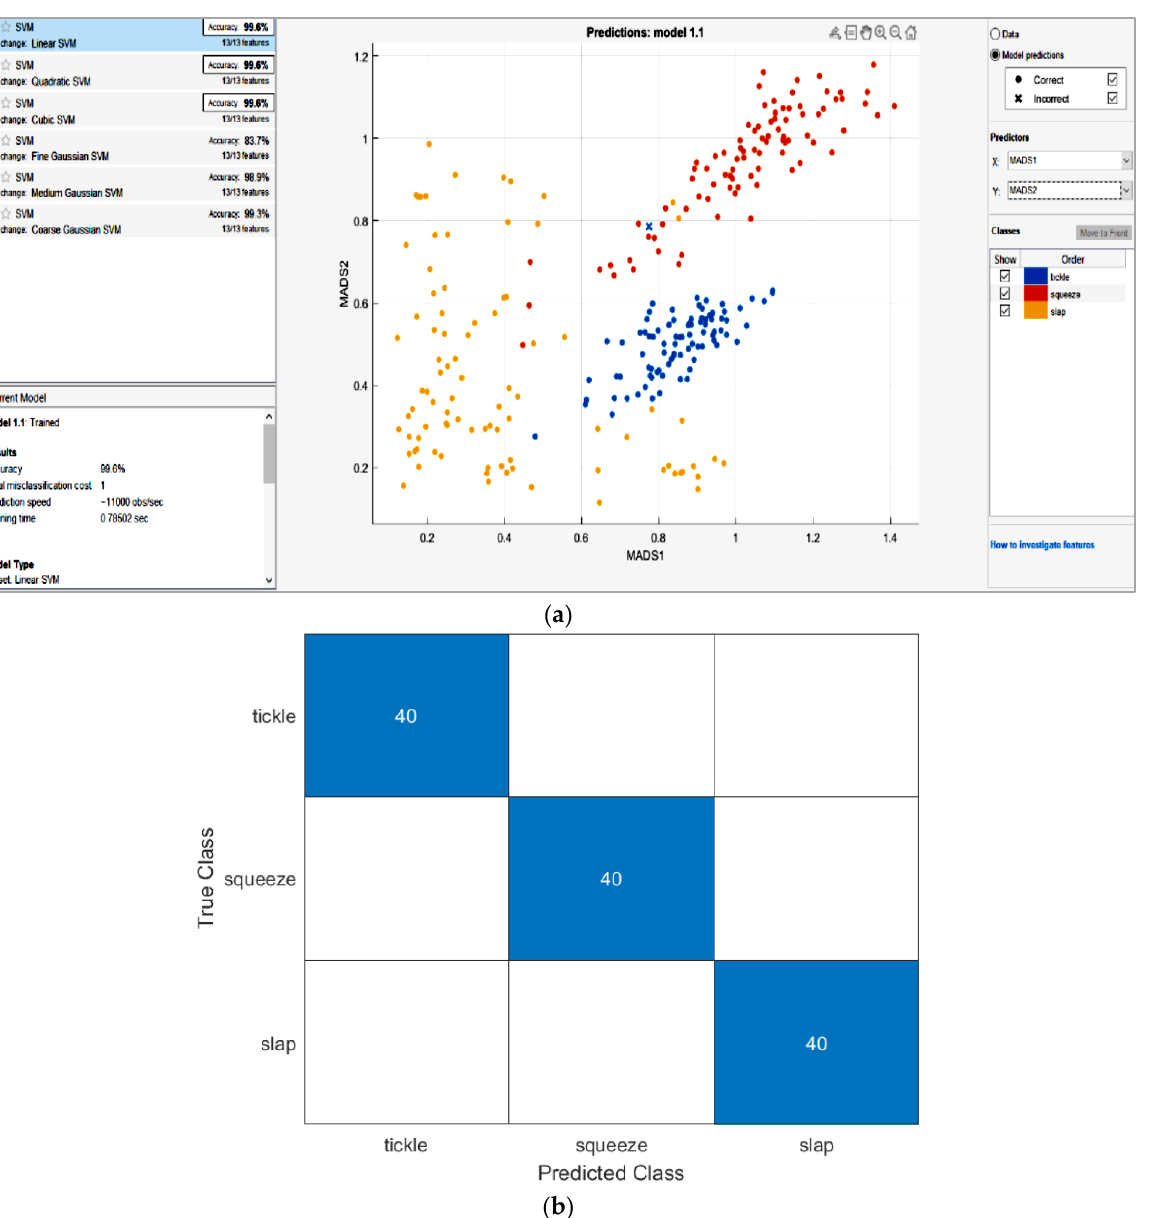
Figure 7. ( a ) The classification training algorithm plot and ( b ) Confusion Matrix of round module.